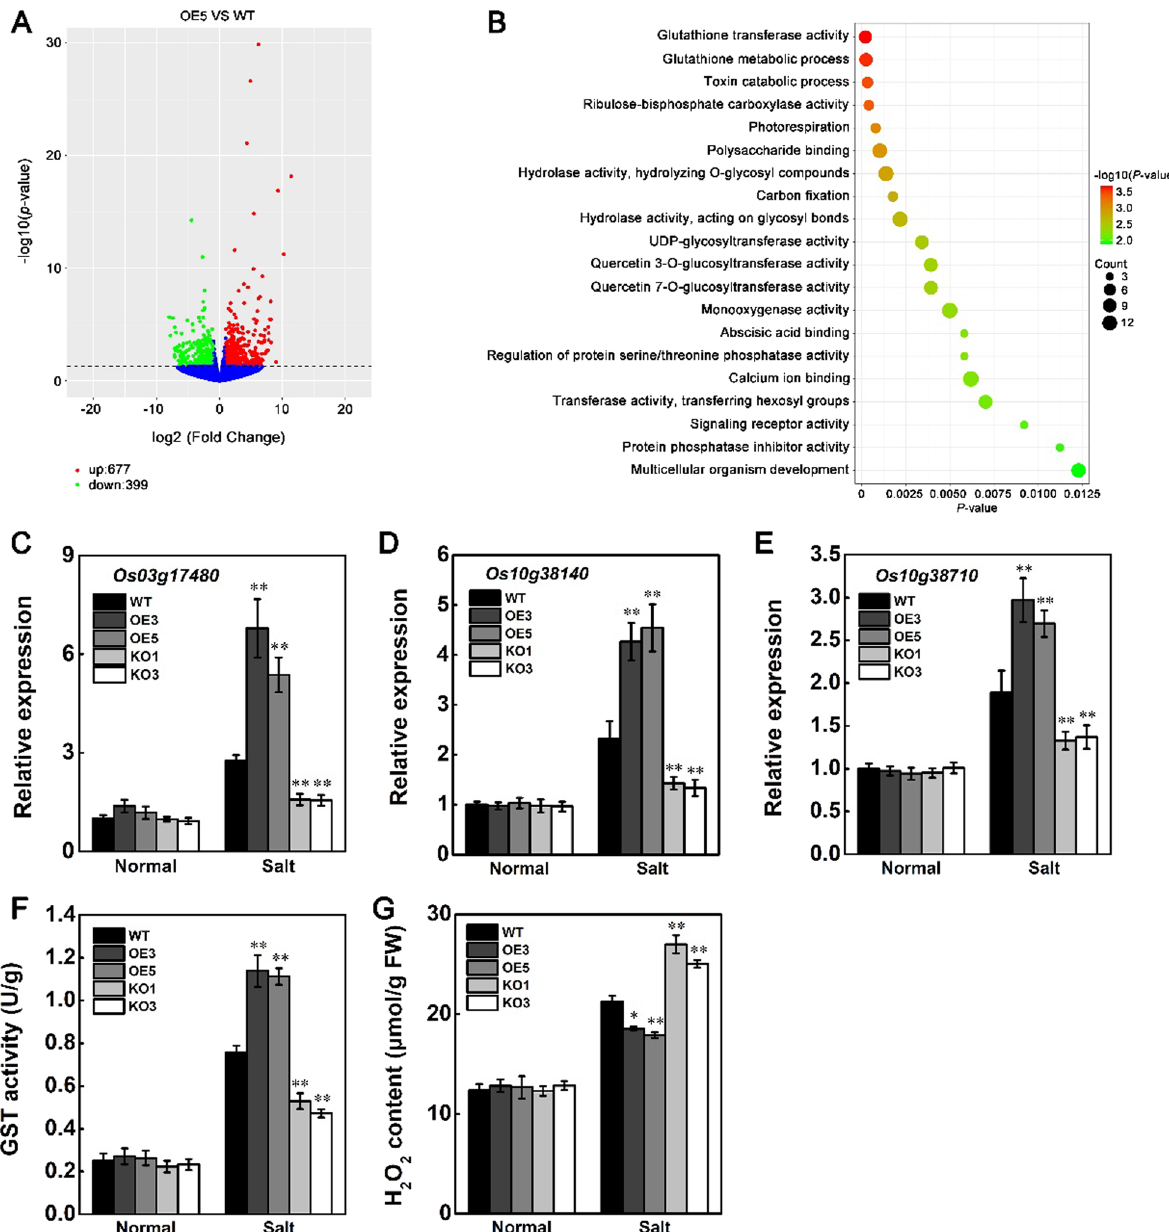
Fig. 7 Differentially expressed genes (DEGs) in the STK -OE plants. A Volcano plots comparing the transcriptomes of OE5 plants with the WT. X-axis and Y-axis represent log 2 fold change (FC) and log 10 (p-value), respectively. The green and red dots represent downregulated DEGs and − upregulated DEGs, respectively. The blue dots represent no significant difference in transcriptomes. B Gene ontology (GO) enrichment analysis of DEGs. TOP 20 significantly enriched biological process GO terms are show. Three biological replicates were included for each treatment. C – E Relative expression of GST genes Os03g17480 ( C ) Os10g38140 ( D ) and Os10g38710 ( E ) in rice leaves of seedlings grown under normal conditions or after 150 mM NaCl for 48 h. F GST activity in rice leaves of seedlings grown under normal conditions or after 150 mM NaCl for 48 h. G H 2 O 2 contents in rice leaves of seedlings grown under normal conditions or after 150 mM NaCl for 48 h. Data in ( C – G ) are presented as mean ** P 0.01, Tukey’s ≤